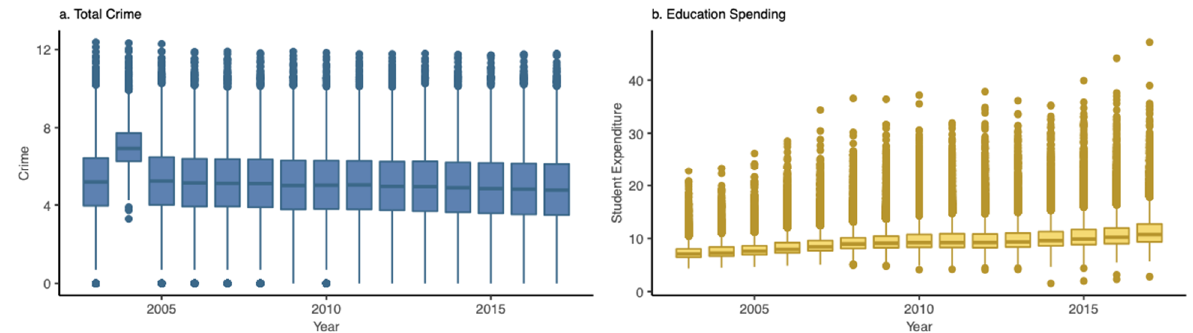
Figure 1. Yearly changes in student expenditure, total crime, and proportion 5–17 year-olds living in poverty (by school districts) over the 15-year period from 2003–2017. Crime values represent the log transformation of actual crime values; student expenditure (thousands of dollars) and proportion children living in poverty remain untransformed. One can see a steady increase in education spending and a steady decrease in crime. (2004 crime is unrepresentatively high because the FBI did not release crime data for cities and towns below 10,000